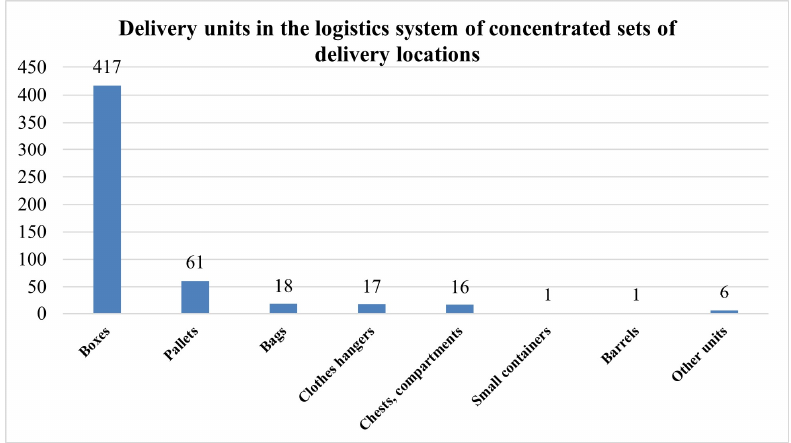
Figure 2. Delivery units in the logistics system of concentrated sets of delivery locations ( N = 475).